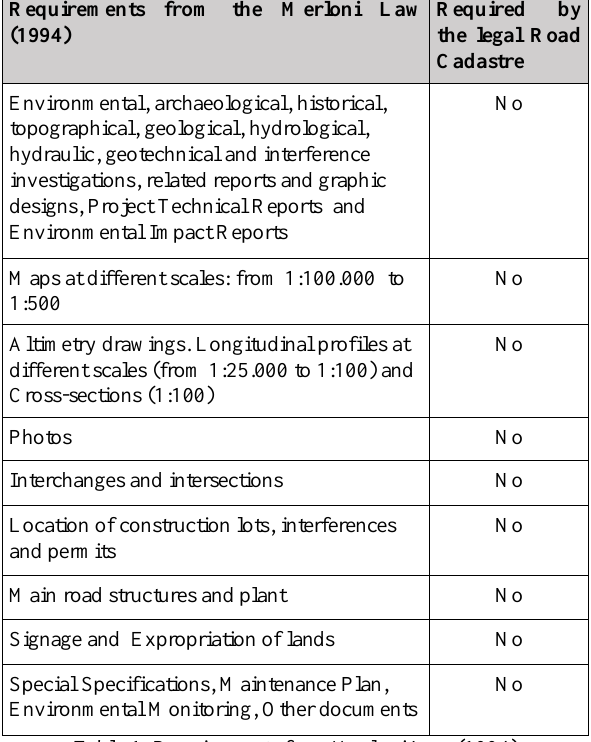
Table 1. Requirements from Merloni Law (1994)